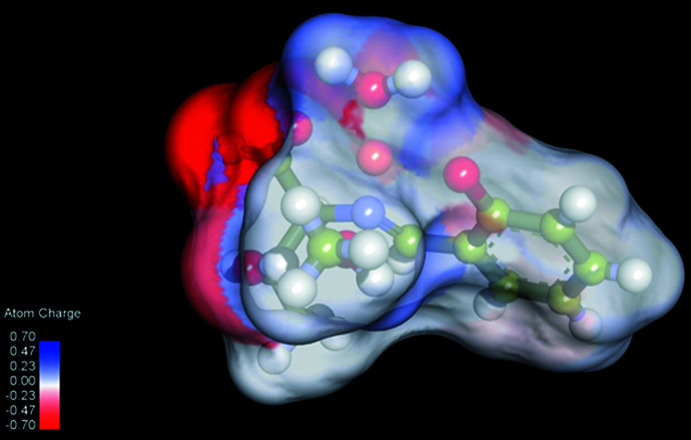
Distribution of atomic charges (red: negative, blue: positive) on the Hirshfeld surface.